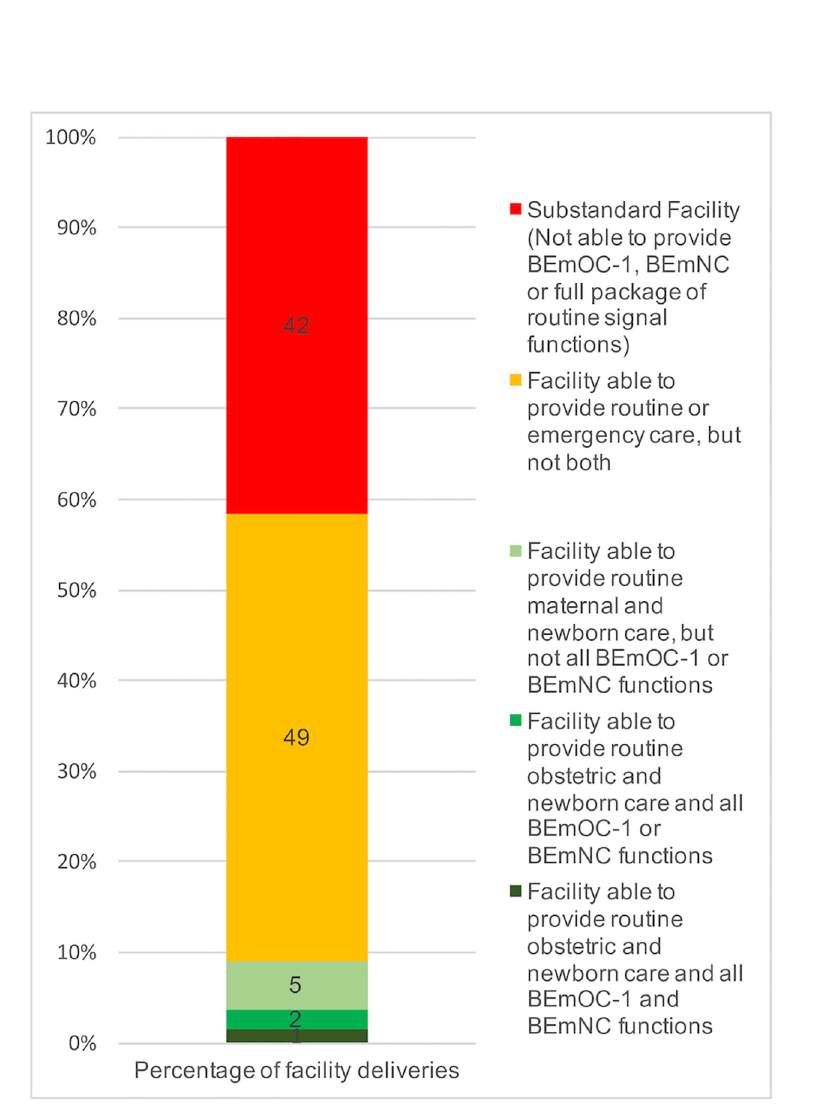
Fig 7. Where the facility births are occurring, by childbirth care